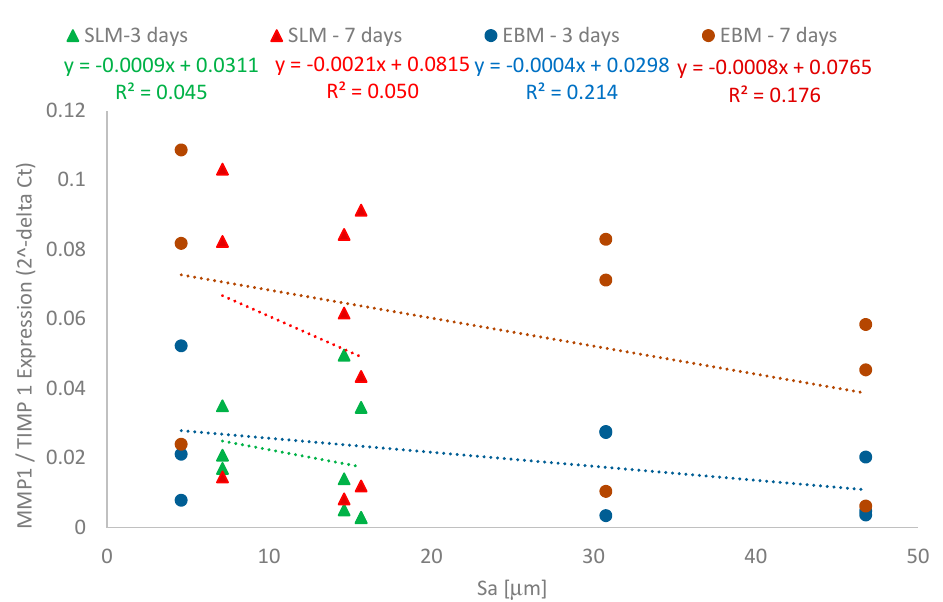
Figure 6. Correlation between the surface roughness (Sa) and collagen synthesis of human osteoblasts. The osteoblasts were cultured under static conditions (3 and 7 days).